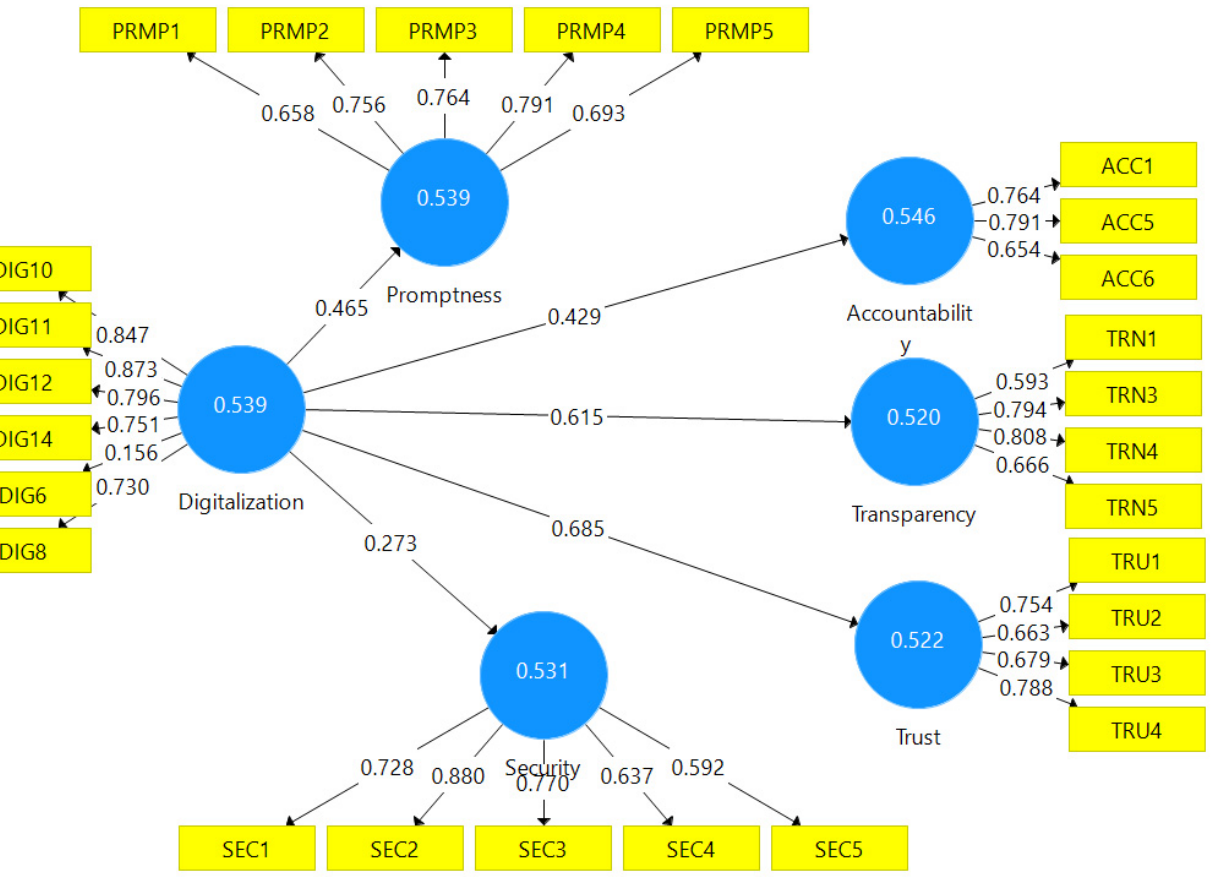
Figure 3. Average Variance Extracted. Note: DIG = Digitalization, ACC = Accountability, SEC = Se- curity, TRU = Trust, TRN = Transparency, PRMP = Promptness. SEC = Security, TRU = Trust, TRN = Transparency, PRMP = Table 2. The Model’s Reliability and Validity.